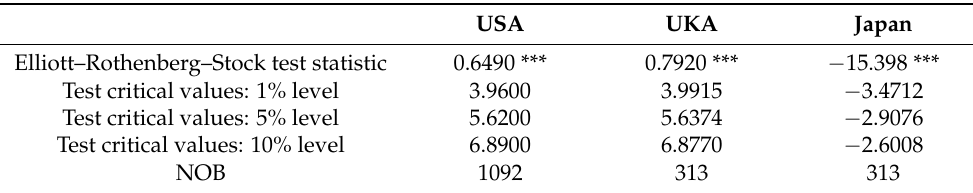
Table 3. Unit root tests: Elliott–Rothenberg–Stock